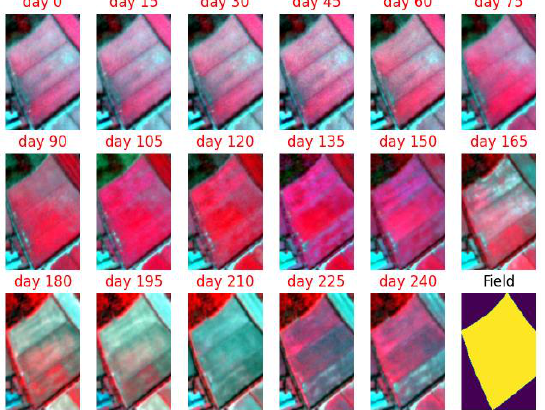
Figure 5. False-color images of a field in our dataset with 15 days cadence